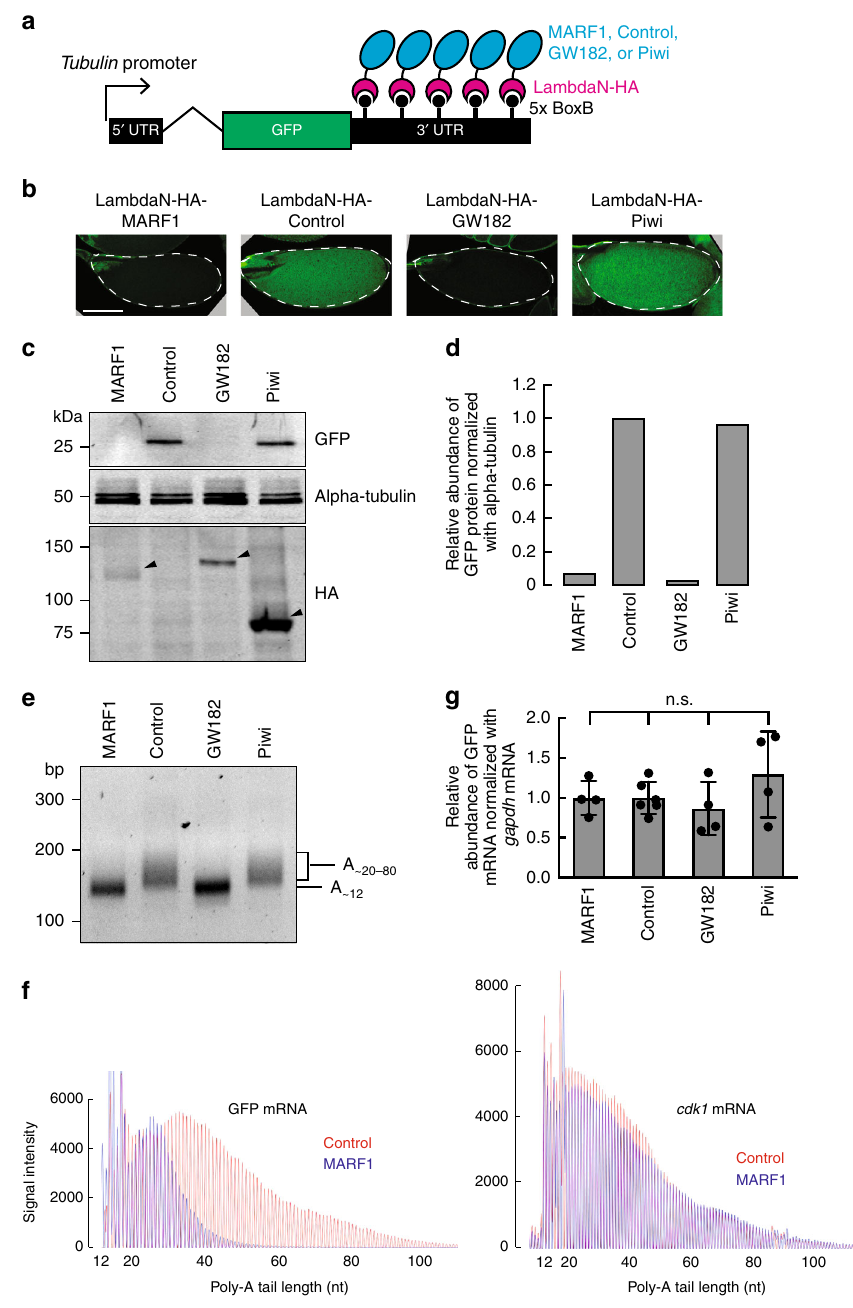
Fig. 7 Tethered MARF1 shortens reporter mRNA poly-A tail and reduces reporter protein level. a GFP-5x BoxB reporter structure, harboring a ubiquitous tubulin promoter, GFP-coding sequence, and a 3 ′ UTR containing fi ve BoxB hairpins. LambdaN-HA-fused control peptide, MARF1, GW182, and Piwi under a UASP promoter were expressed in germline cells using maternal-alpha-tubulin-Gal4 driver. b Confocal images of GFP signal in stage 14 oocytes. Scale bar is 100 μ m. c Western blots using stage 14 oocyte lysates. Black triangles indicate the transgenic lambda-HA-fused proteins. d Quanti fi cation of band intensities in c . e ePAT assay measuring GFP reporter mRNA poly-A tail length in stage 14 oocytes. The ampli fi ed DNA sizes were analyzed on an agarose gel. f ePAT assay measuring poly-A tail lengths of GFP reporter mRNA and a negative control cdk1 mRNA in stage 14 oocytes. Ampli fi ed DNA sizes were analyzed by capillary fragment analysis. g Relative abundance of GFP-5xBoxB mRNA normalized by gapdh mRNA determined by qRT-PCR. Mean ± SD ( n = 6 for the control and n = 4 for all the